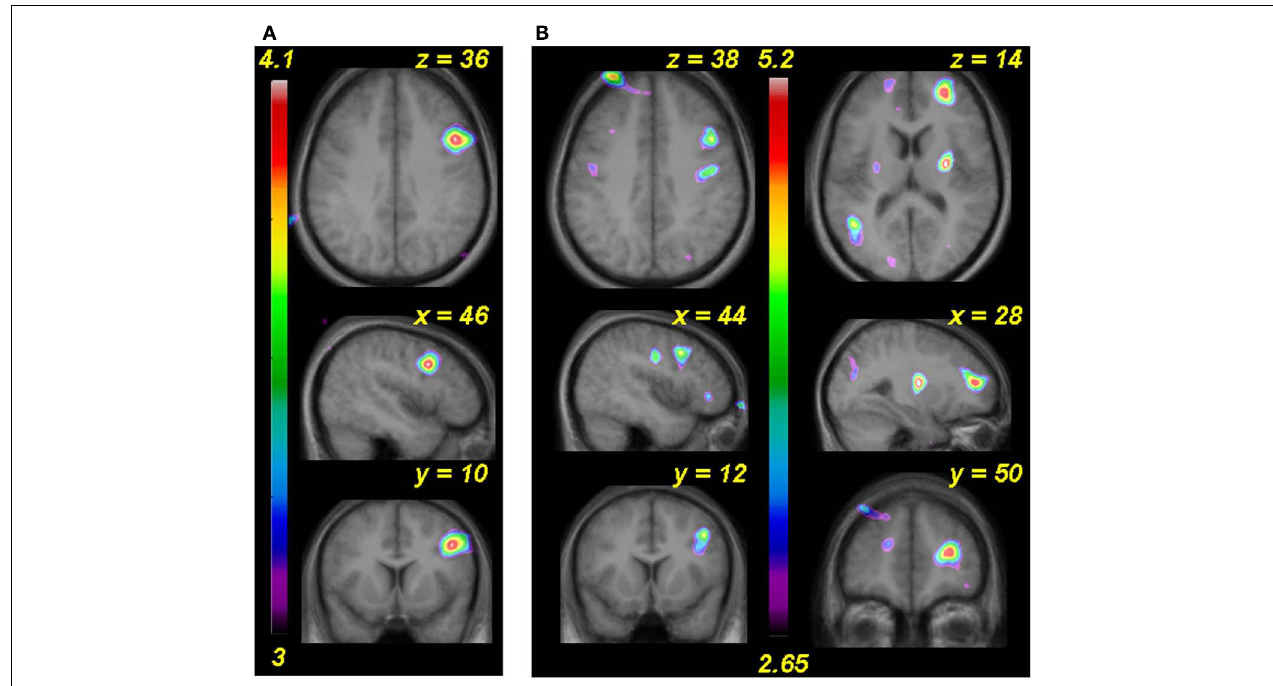
FIGURE 9 | (A) Functional MRI data for the analysis comparing post-training to pre-training global BOLD changes in the passive task versus silence. (B) As in (A) but for active task. In both cases an area of the right dorsolateral frontal cortex shows more activity after